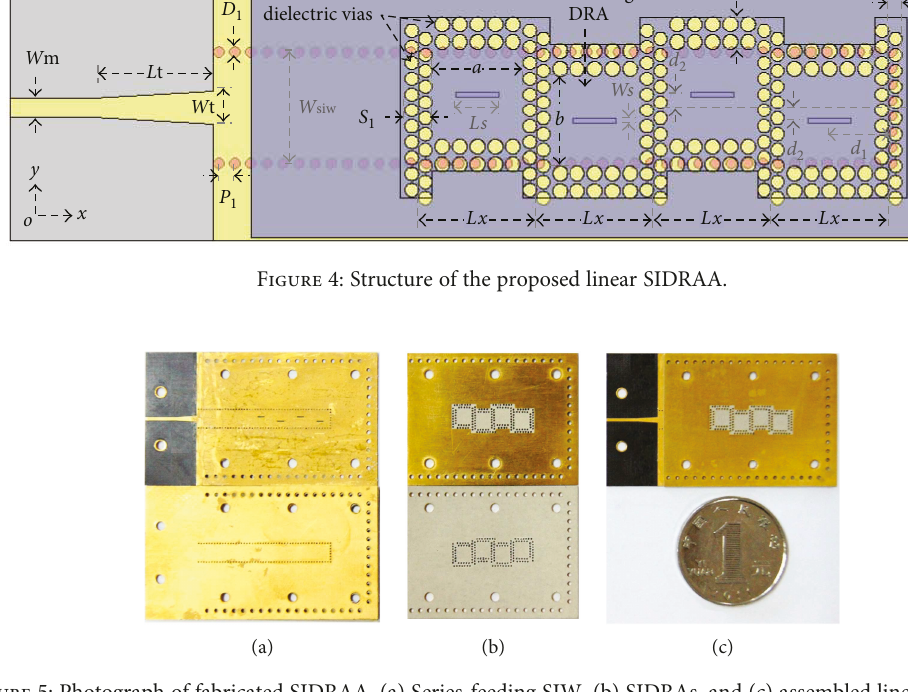
Figure 5: Photograph of fabricated SIDRAA. (a) Series-feeding SIW, (b) SIDRAs, and (c) assembled linear SIDRAA.